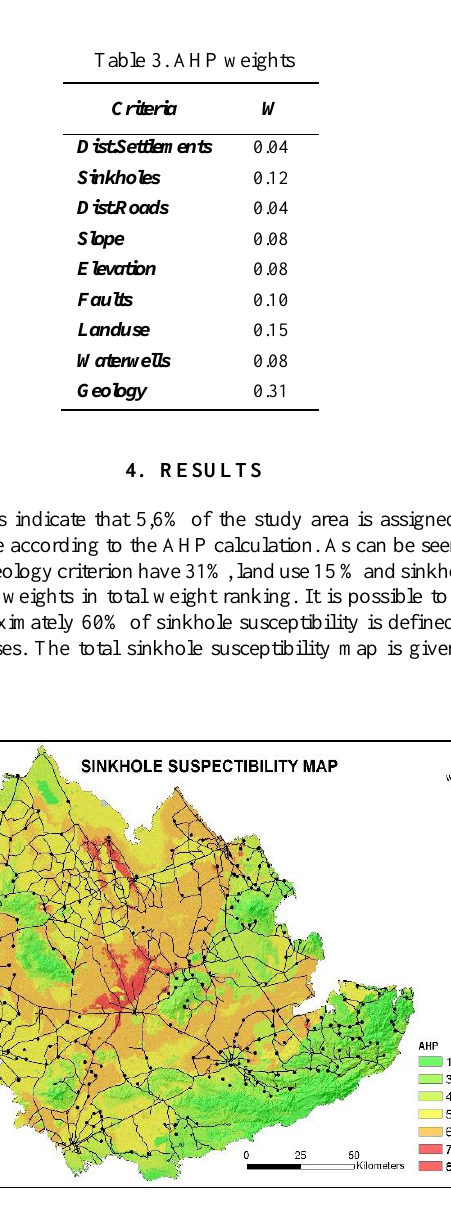
Figure 4. Suitability map